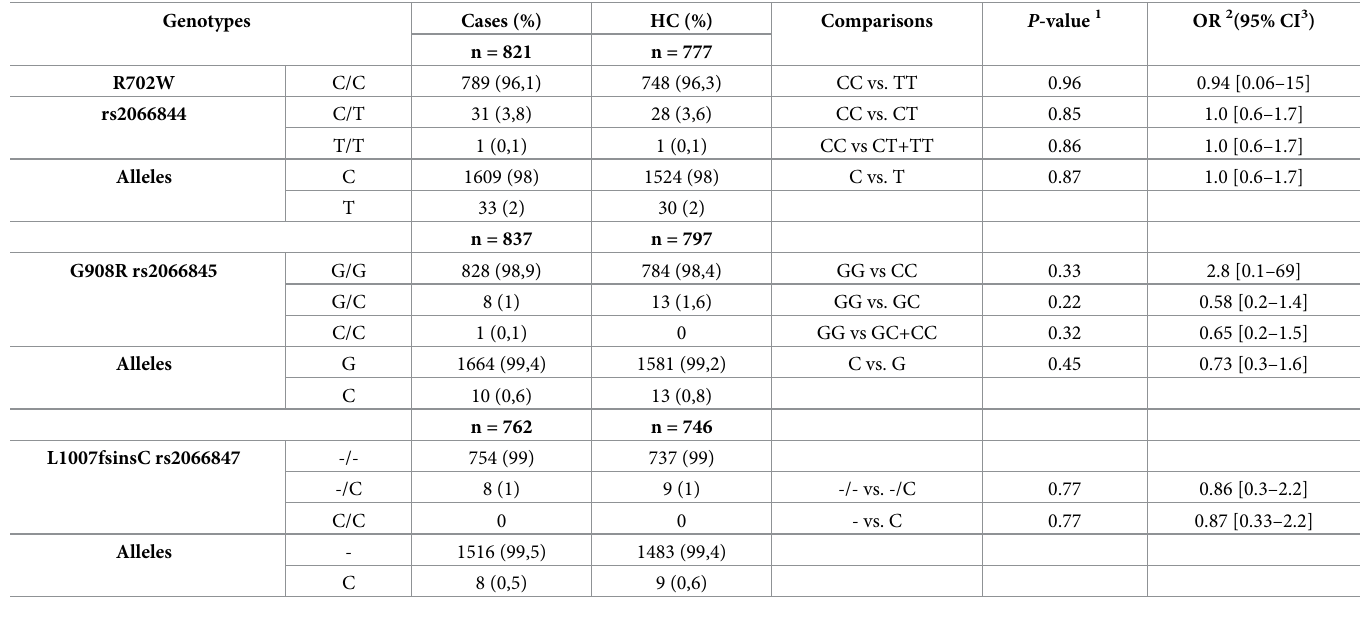
For the frameshift variant L1007fs, the minor allele frequency (MAF) was 0.5% among the patients with Lg -CL and 0.6% in the HC group. Only eight individuals (1%) among the patients with Lg -CL and nine (1%) among the HC were heterozygotes for the L1007fs variant. For the R702W, 31 (3.8%) and 28(3.6%) were heterozygotes in the patients and HC groups, respectively. Similarly, only eight (1%) and 13 (1.6%) individuals were heterozygotes for G908R among the patients with Lg -CL and HC, respectively. None of the variants revealed any association with either susceptibility or protection to Lg -CL. (Table 3) showed the statistical comparisons between the patients with Lg -CL and HC according to inheritance models and revealed no association with susceptibility to Lg -CL. Table 2. Genotypes and alleles frequencies of the variants R702W, G908R, and L1007fsinsC of the NOD2 gene among patients with Lg -CL (cases) and healthy con- trols (HC).